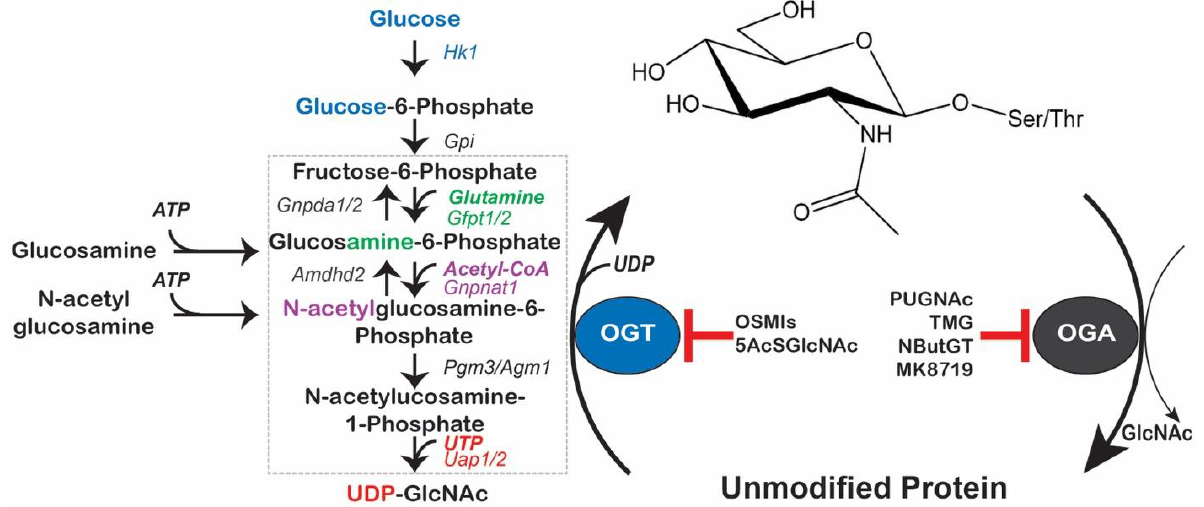
Figure 1. O-GlcNAc cycling. O-GlcNAc is cycled on and off proteins by two enzymes: The O-GlcNAc transferase (OGT) and O-GlcNAcase (OGA), that catalyze the addition and removal of O-GlcNAc, respectively. OGT uses the nucleotide sugar UDP-GlcNAc, which is synthesized by the hexosamine biosynthetic pathways (boxed). Commercially available inhibitors of OGT and OGA are highlighted. Adapted from [1].